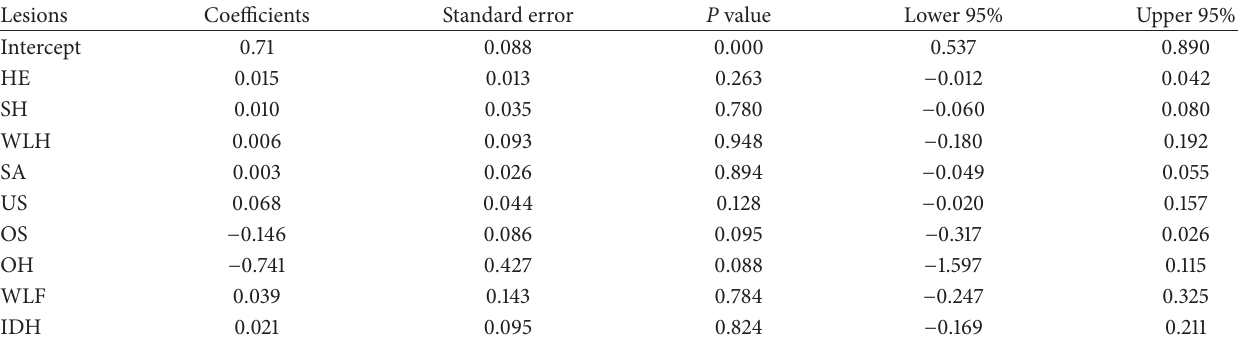
Table 2: Association between locomotion scores (0 and 1) and various